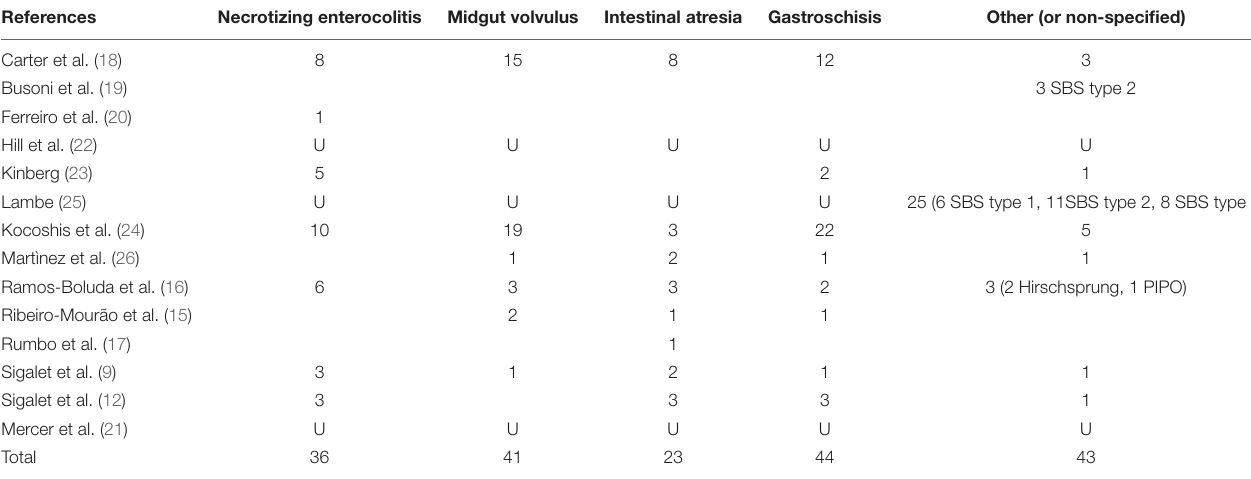
TABLE 3 | Causes of intestinal resection.